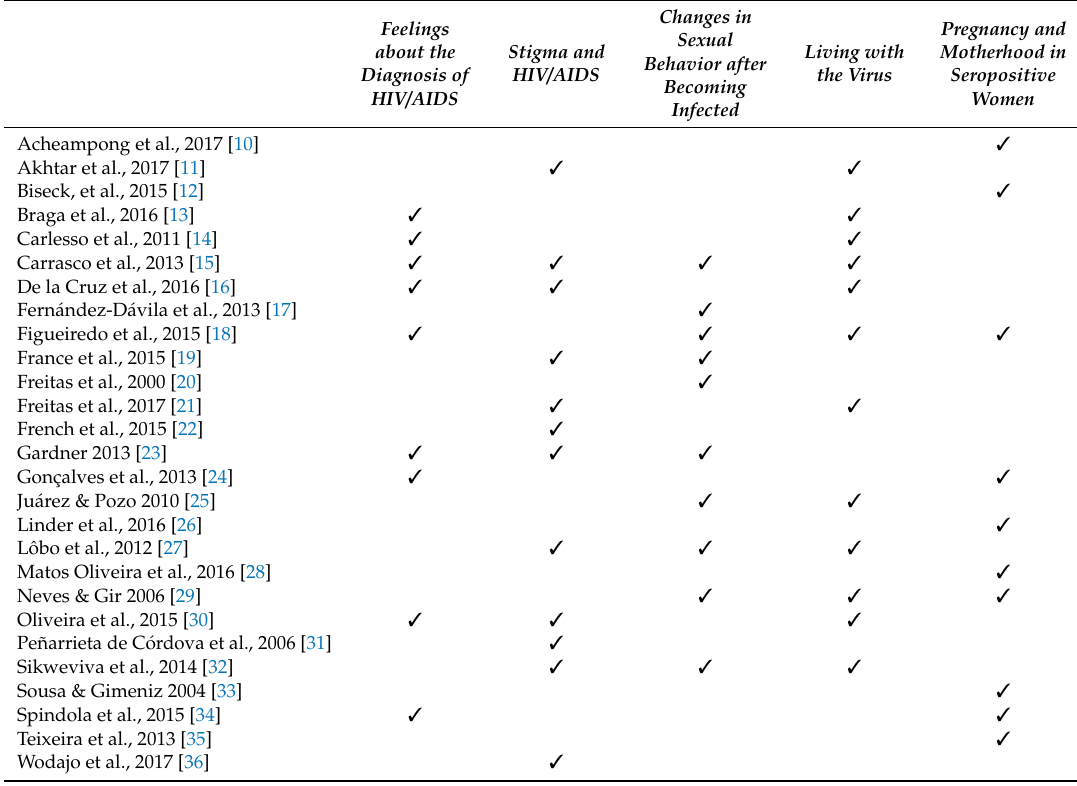
Table 2. Categories identified in each